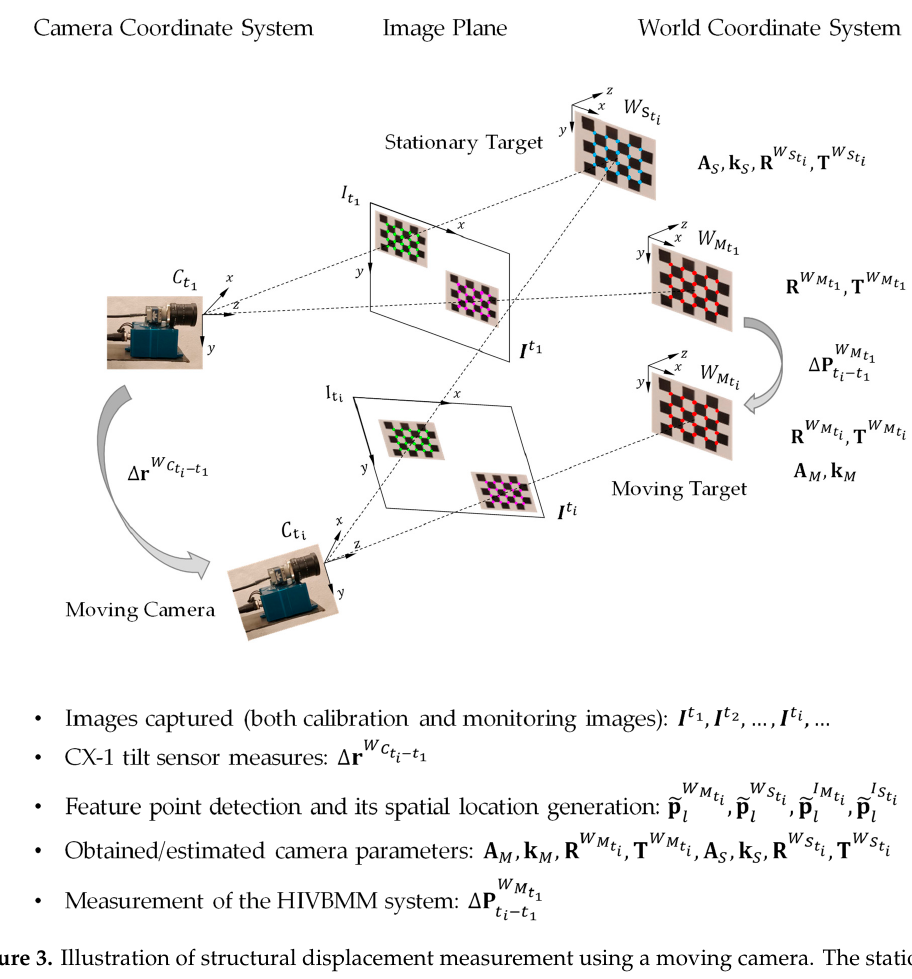
Figure 3. Illustration of structural displacement measurement using a moving camera. The stationary calibration target is assumed to have the same movements with the stationary structure, and the moving calibration target is assumed to have the same movements with the structure that is being monitored. Both the stationary and moving calibration targets are required to place within the same FOV of the camera. The calibration images (need to cover the whole camera FOV) are taken before the monitoring images. For better visualization, only the monitoring images I t 1 , I t i are